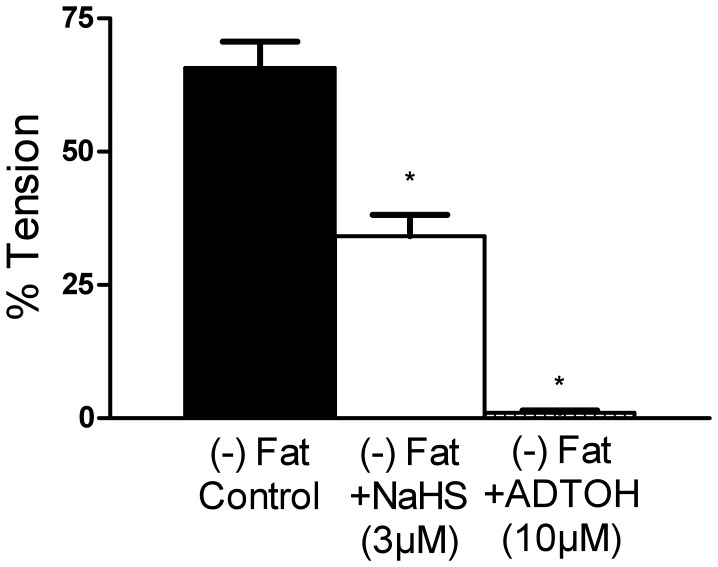
NaHS and ADTOH induced relaxations of (−) Fat mouse aortas.Mouse aortic rings were precontracted with 5-HT (1 µmol/l). Tension was recorded after 30 min. * p<0.05. n = 16 in (−) Fat control. n = 11 in NaHS group. n = 8 in ADTOH group.